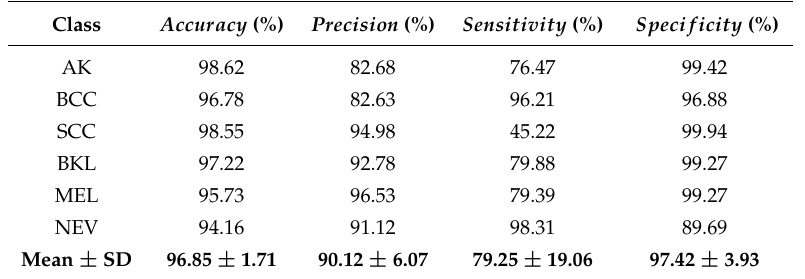
Table 5. The performance metrics obtained for Exp-2 with α = − 1.9. The dataset has 24,839 images.